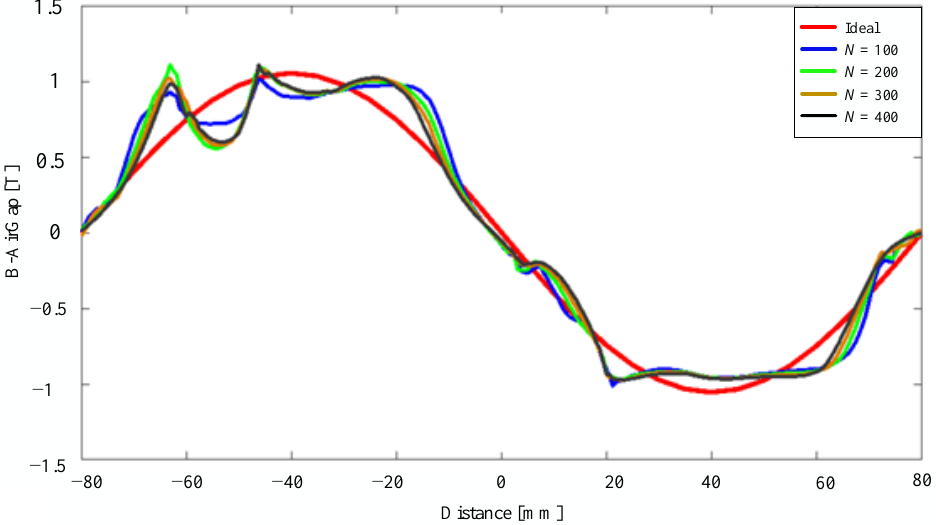
Figure 8. FFT decomposition of flux density with level-set optimization. Table 2 gives the detection values of B with the level-set optimization at m = 33. Figure 9 presents the optimized permanent magnets model of the generator.